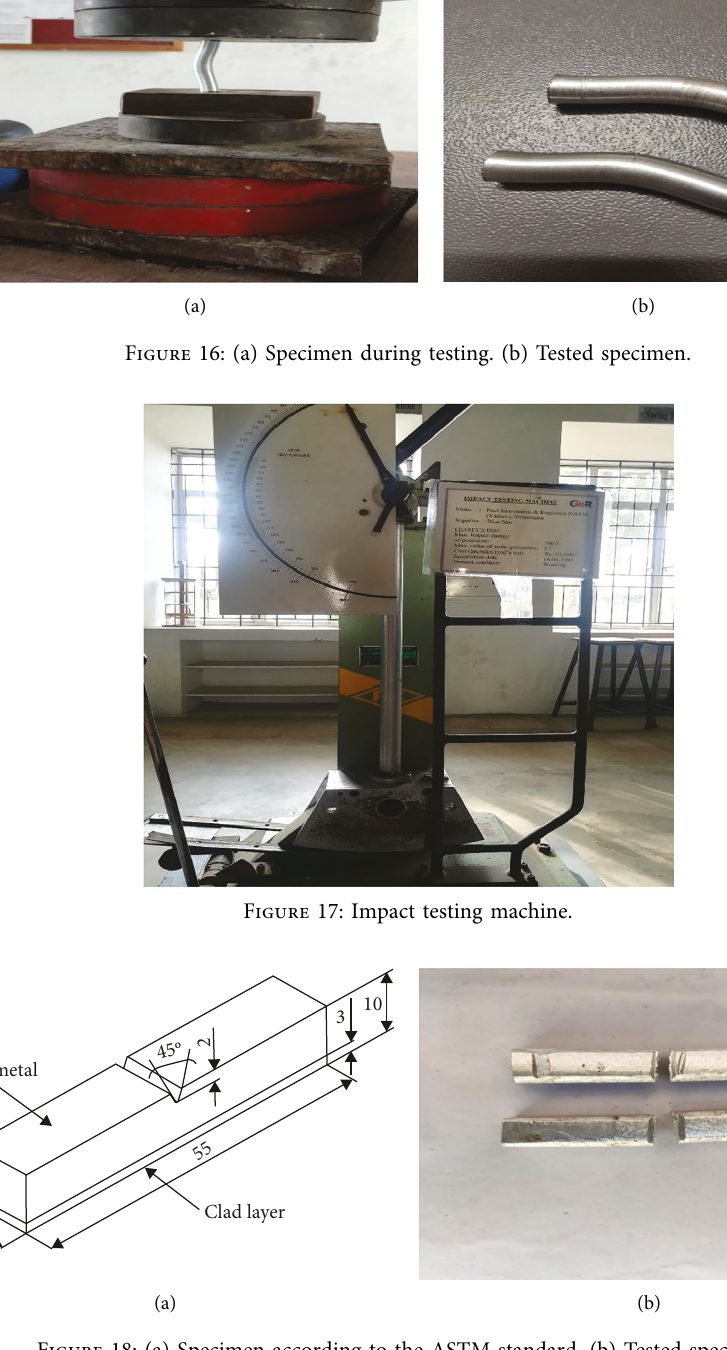
Figure 18: (a) Specimen according to the ASTM standard. (b) Tested specimen.